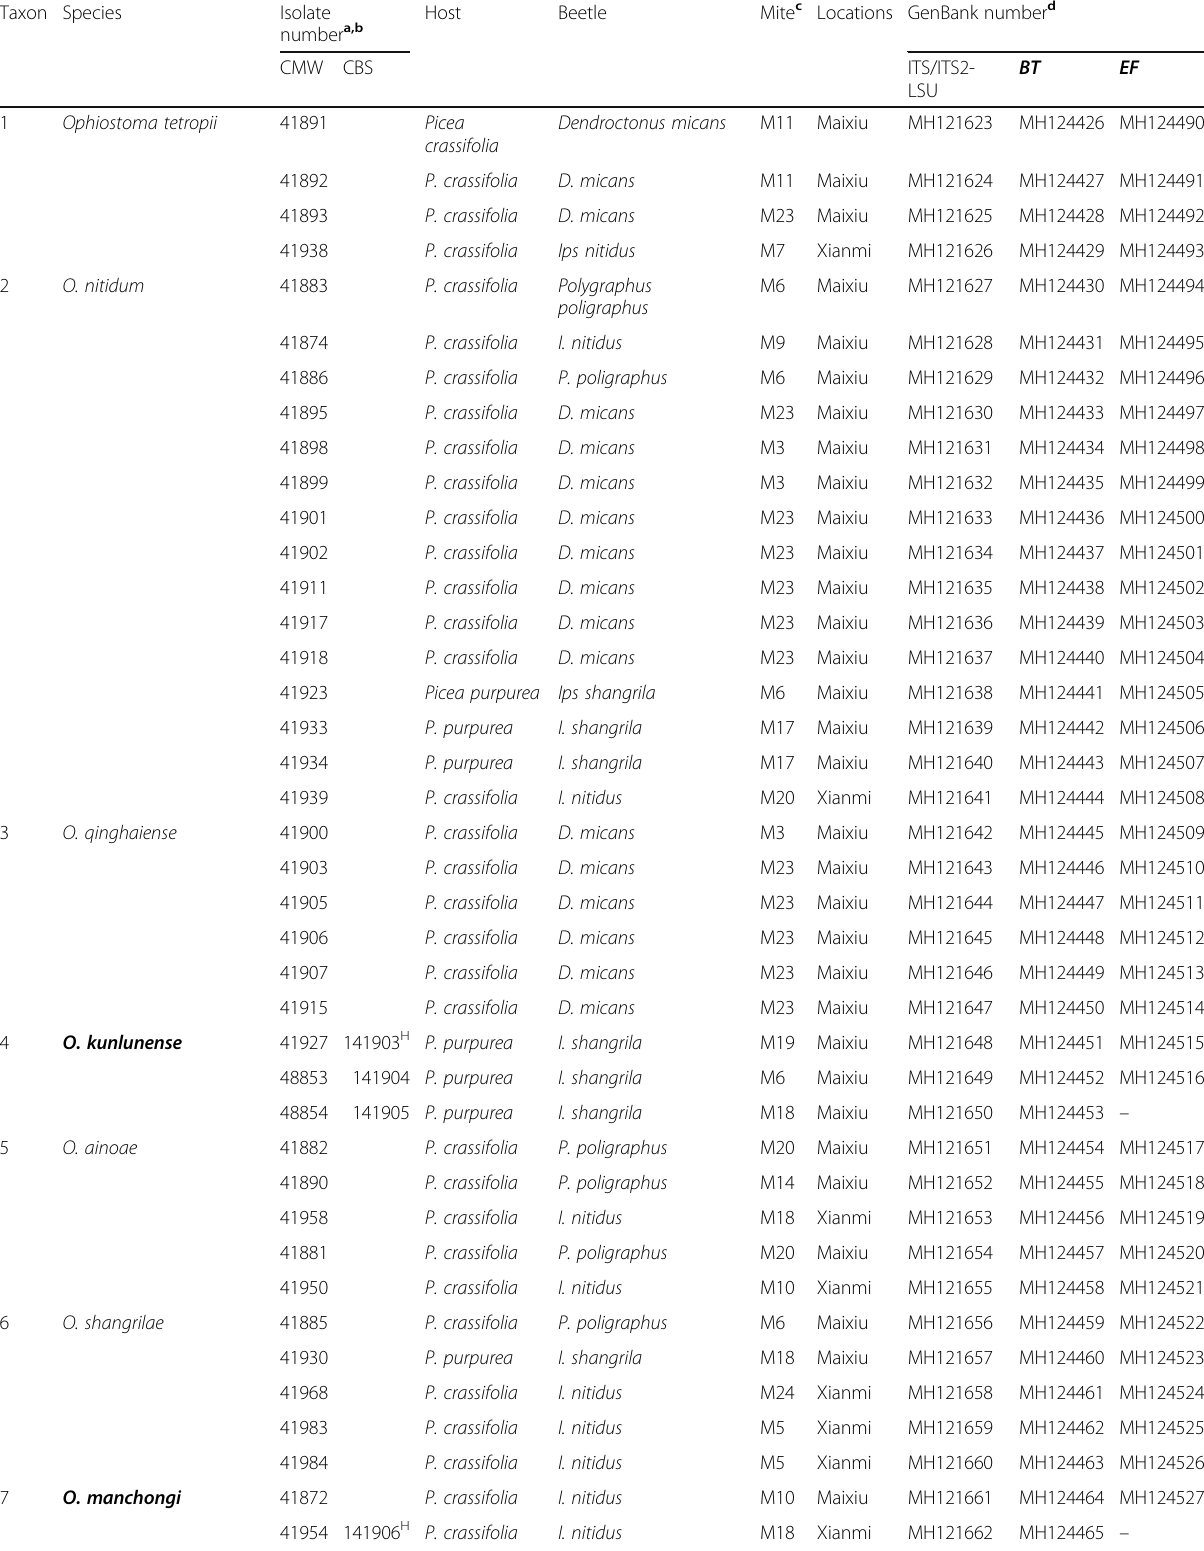
Table 2 Isolates of ophiostomatoid fungi obtained from different mites in Qinghai. Species names of novel taxa are printed in bold